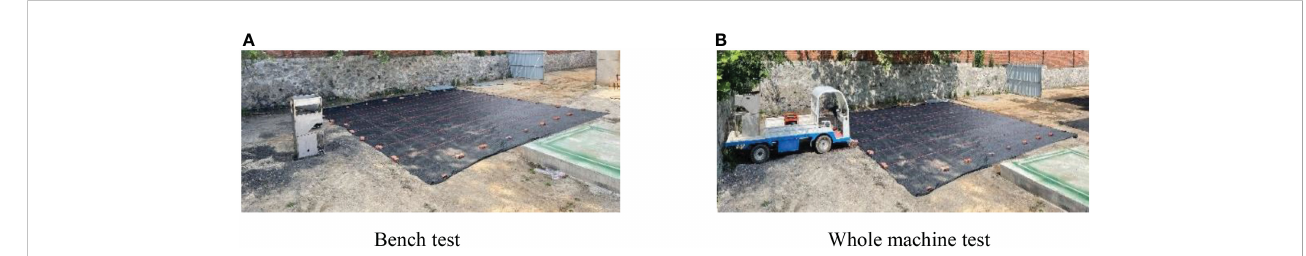
FIGURE 11 Test site. (A) Bench test (B) Whole machine test.